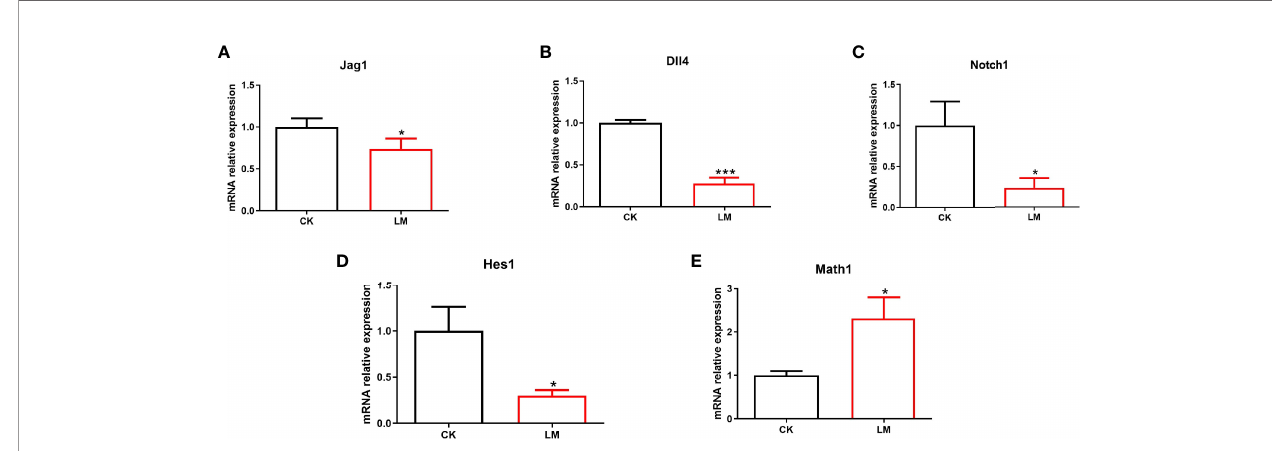
FIGURE 5 | The in fl uence of L. monocytogenes on the Notch pathway in organoids. CK, control; LM, L. monocytogenes -infected group. (A-E) The expression of Jag1 , Dll4 , Notch1 , Hes1 and Math1 genes were determined by quantitative RT-PCR and normalized by the expression of GAPDH . Data is presented as mean ± SD. * P < 0.05, *** P < 0.001. Data combined from at least three independent experiments unless otherwise